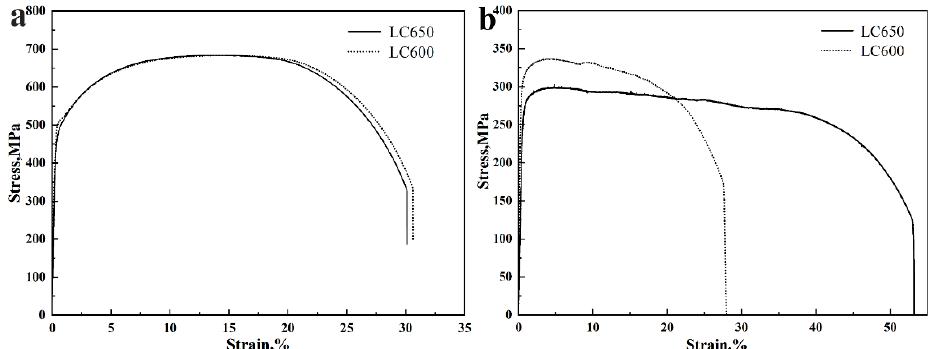
Figure 4. Tensile stress–strain curve of experimental steels at room temperature and at 600 °C. ( a ) Tensile test at room temperature, and ( b ) tensile test at 600 °C.